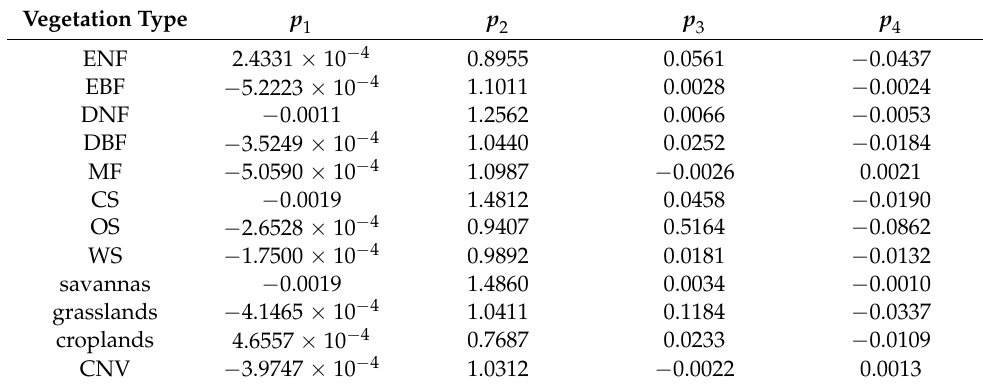
Table A1. The values of p 1 , p 2 , p 3 , and p 4 for the 12 vegetated types. Vegetation